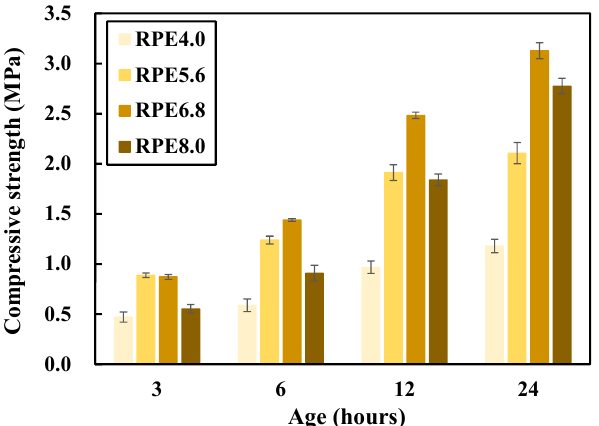
Figure 2. Compressive strength measurement results used to select the optimal concentration of epoxy emulsion in the red clay binder.